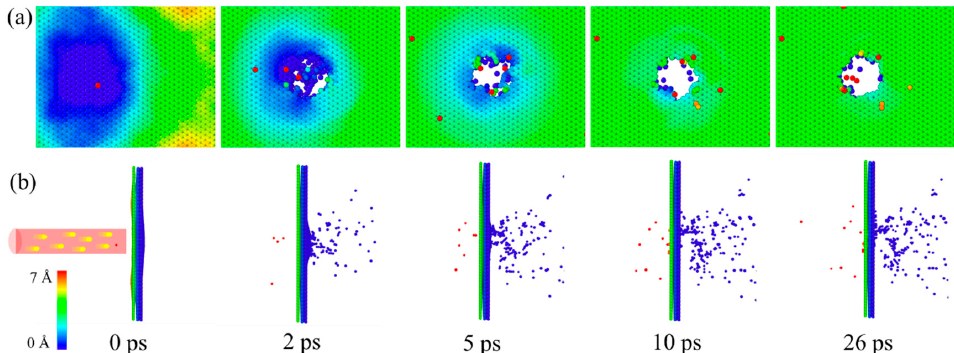
Figure 2. Structural evolution of the G/M heterostructure under ion irradiation. ( a ) Front view, and ( b ) left view. Ion energy is 200 eV, ion dose is 1.27 × 10 16 /cm 2 . The atoms are colored according to the z coordinates. z is defined as the coordinate axis along the irradiation direction.